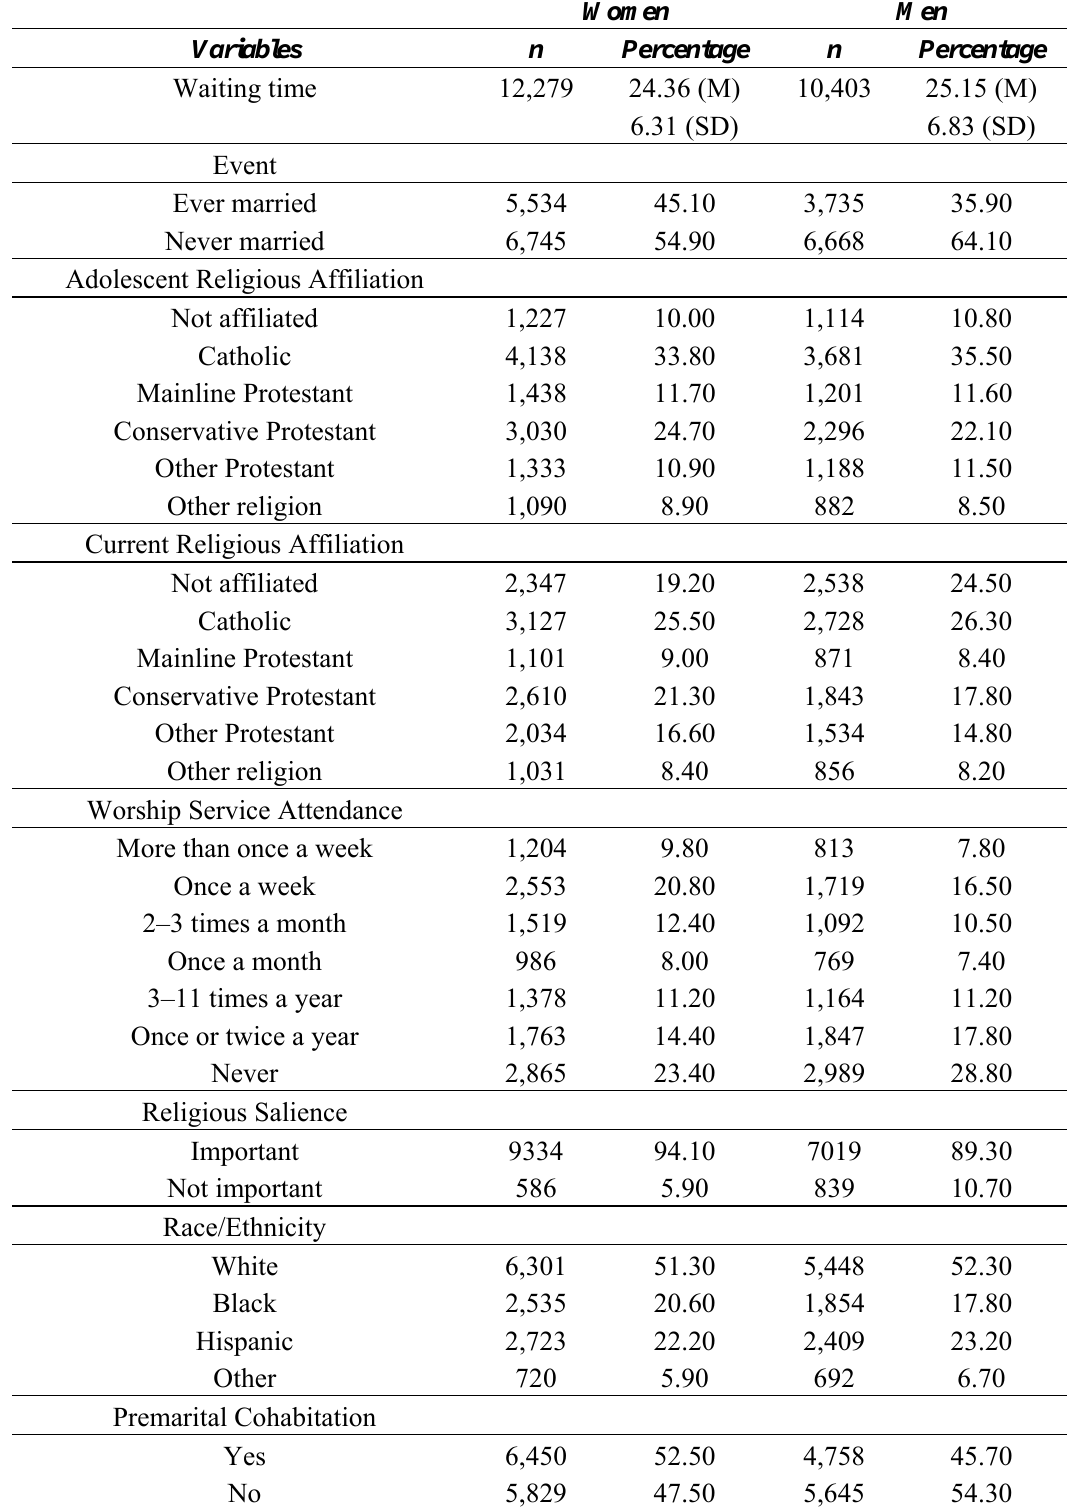
Table 1. Sample Characteristics by